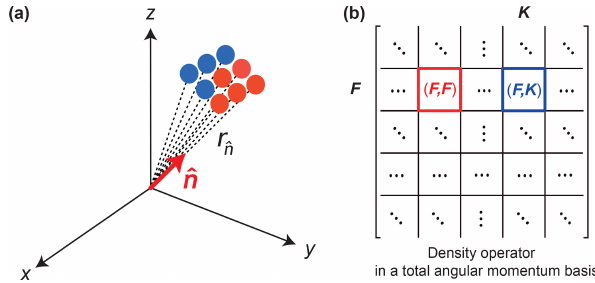
Figure 1. (a) The visualized surface is a collection of points plotted at a distance r ˆ n from the origin along the direction ˆ n (red color rep- resents a positive number and blue color represents a negative num- ber). (b) Density matrix written on a total angular momentum ba- sis. In such a basis, the density operator is decomposed into blocks according to F (total angular momentum quantum number); the di- agonal block is denoted as ( F,F ) and the off-diagonal block is de- noted as ( F,K ). In the following figures we keep the same axis